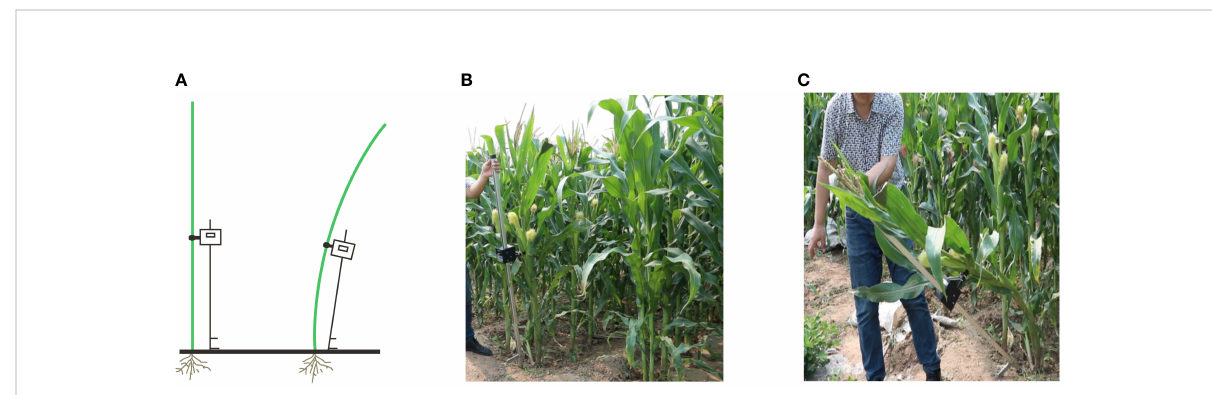
FIGURE 2 Test process of lodging resistance tester. (A) Schematic diagram of instrument placement during a test process. (B) Place the instrument parallel to the plant at the beginning of the test. (C) Pull the instrument vertical rod by hand for